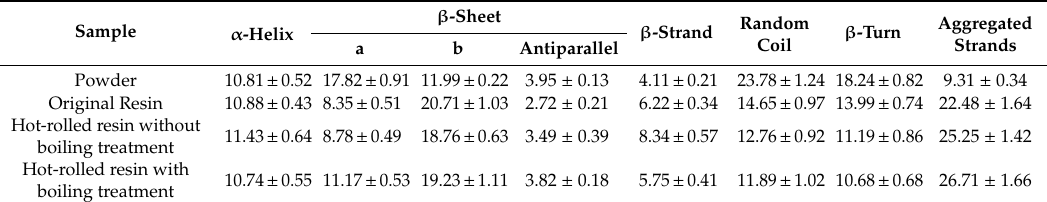
Table 5. The secondary structure content (%) of amide I of RS powder, original RS resin, and the RS hot-rolled resin without and with boiling treatment.